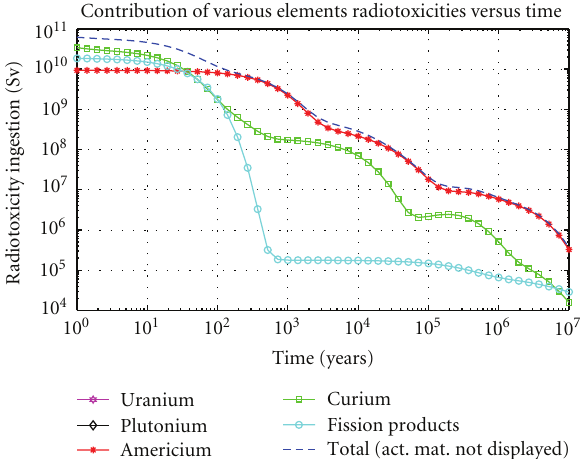
Figure 20: Contributions to radiotoxicity versus time—GCFR SNF end second cycle.